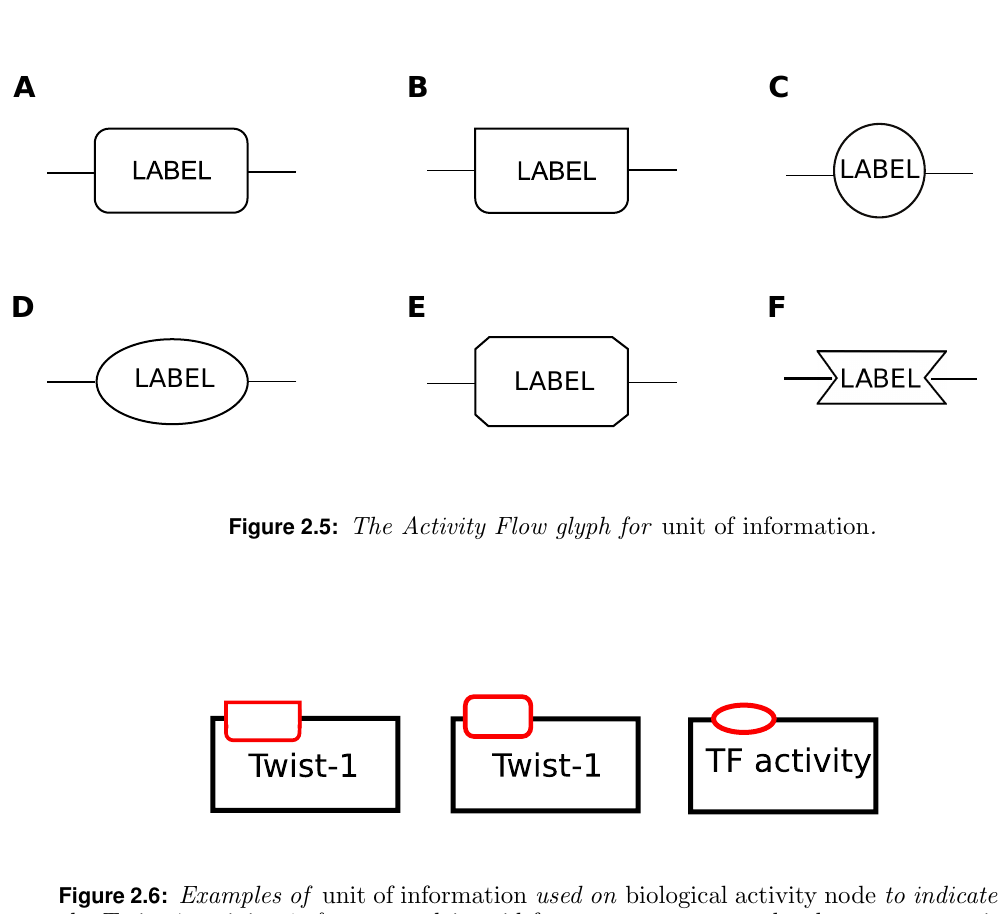
Figure 2.6: Examples of unit of information used on biological activity node to indicate that the Twist-1 activity is from a nucleic acid feature or a macromolecule , or a transcription factor activity from an unspecified